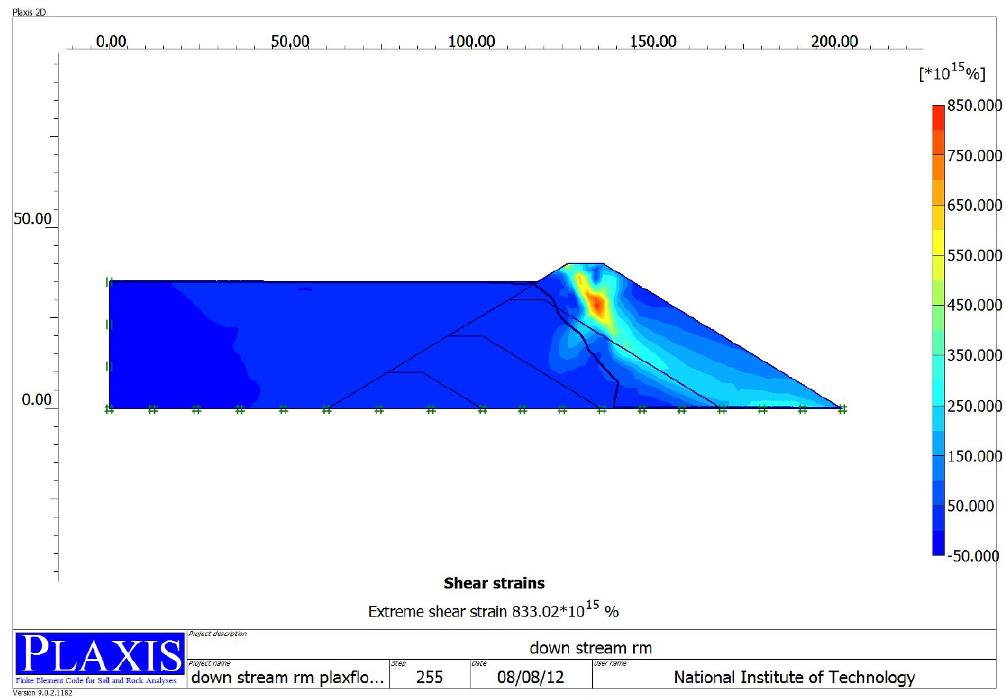
Figure 17. Strain diagram dam in downstream method case showing the failure surface